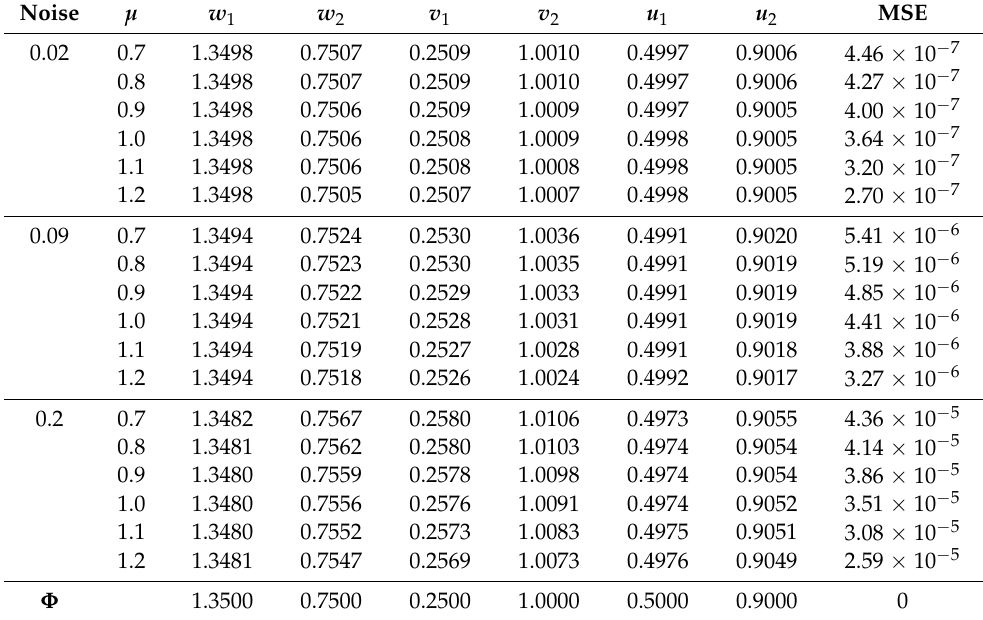
Table 2. MSE results of HQFGD for different noise levels for α =